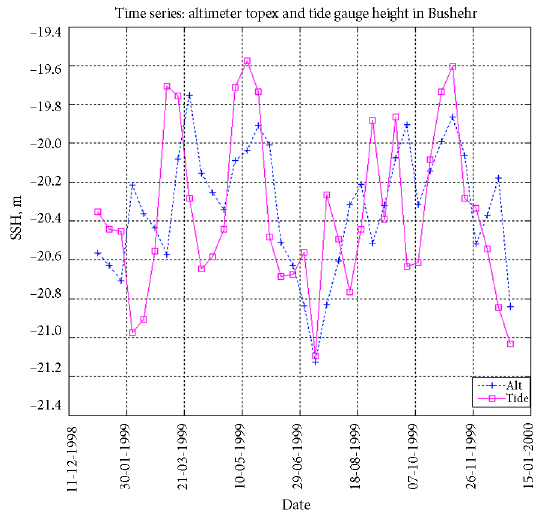
Fig. 5. SSH time series obtained from Topex/Poseidon against those of Bushehr tide gauge over a 1-year time span from 1999 to 2000